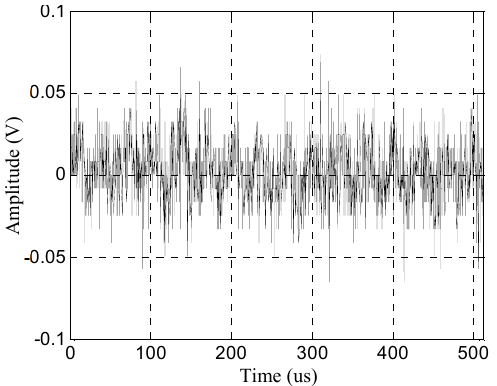
Figure 10 The original signal for detecting honeycomb sandwich composite material. Figure 10. The original signal for detecting honeycomb sandwich composite